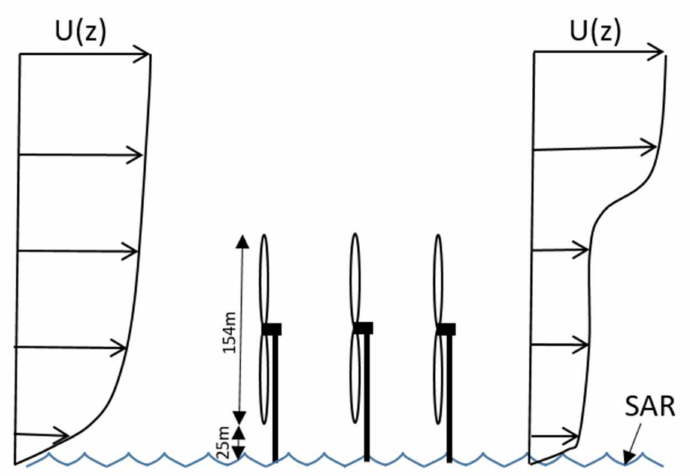
Figure 2. Sketch of the wind profile upstream and downstream of a wind farm. The distance from the water surface to the rotor plane and the rotor diameter from Westermost Rough are